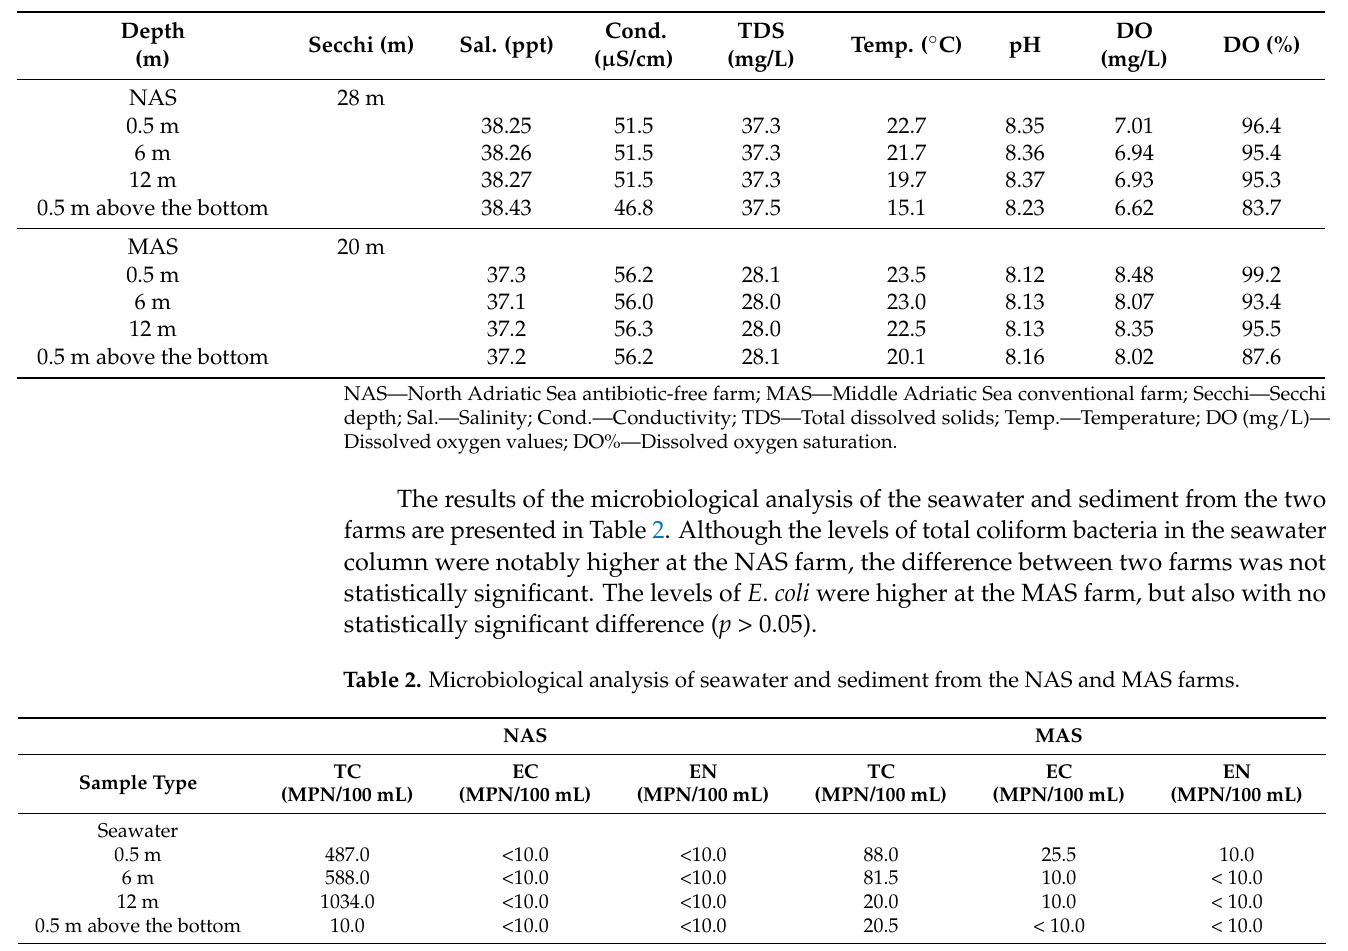
Table 1. Physicochemical analysis of seawater from the NAS and MAS fish farms.